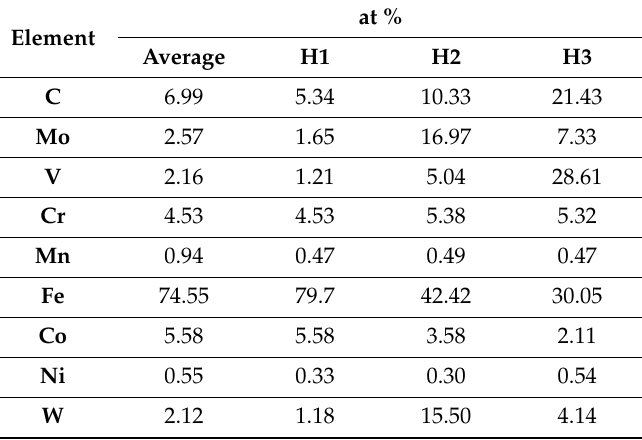
Table 1. Semi-quantitative pointwise EDS analyses of various positions indicated in Figure 3a, compared with the average composition of the complete view-field. The results refer to the spectra in Figure 4; each position was repeated three times and the inherent results are listed here in terms of average atomic percentage.